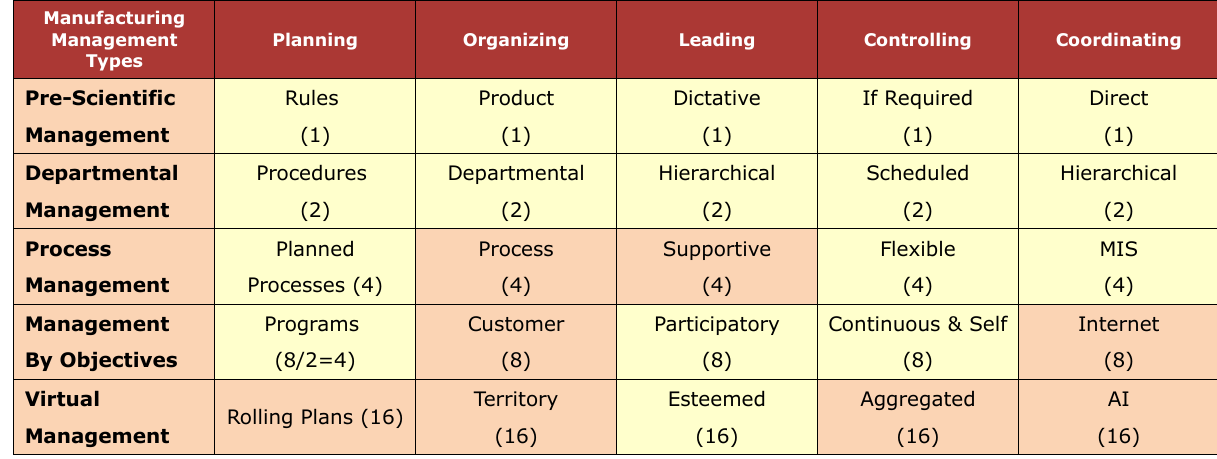
Table 3. Techniques used for Management